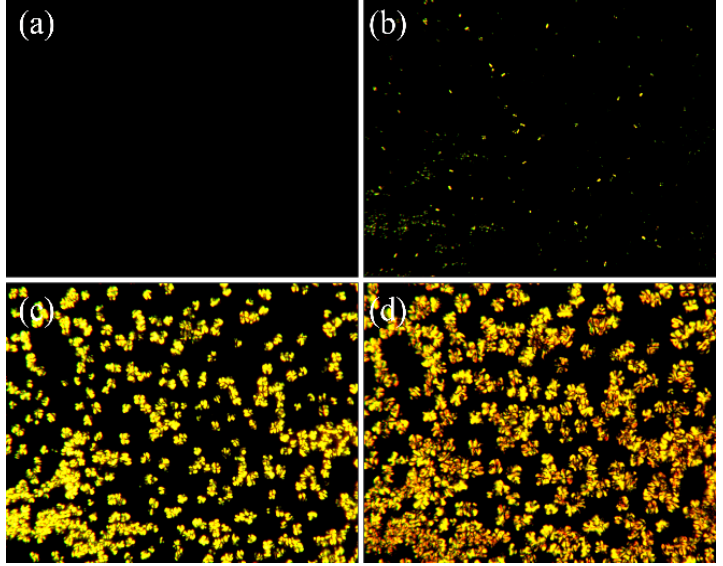
Figure 6. Polaring optical microscopy (POM) of the process of growth of the PEN-Ph crystals at 280 ◦ C. ( a ) 0 min; ( b ) 10 min; ( c ) 30 min; ( d ) 60 min.